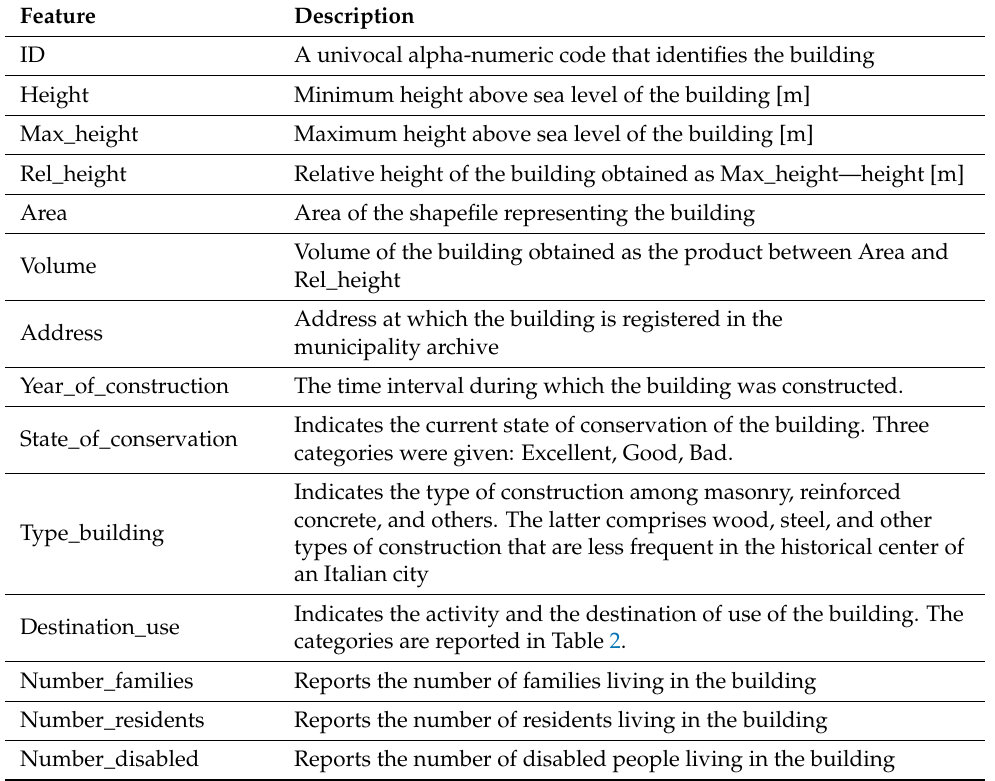
Table A1. Description of the features of the exposure dataset of the city of Monza.